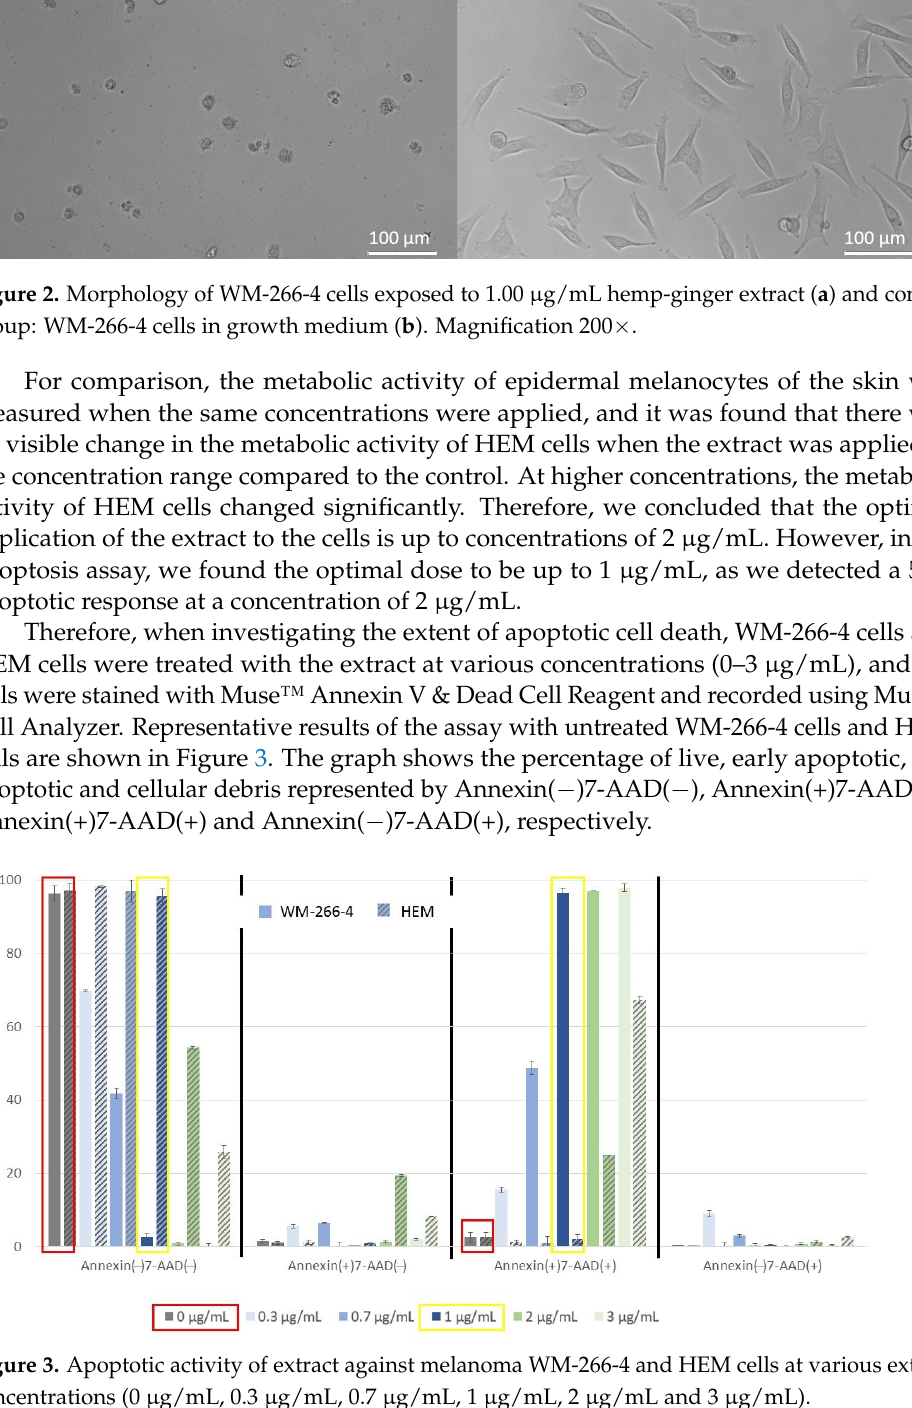
Figure 3. Apoptotic activity of extract against melanoma WM-266-4 and HEM cells at various extract concentrations (0 µg/mL, 0.3 µg/mL, 0.7 µg/mL, 1 µg/mL, 2 µg/mL and 3 µg/mL).